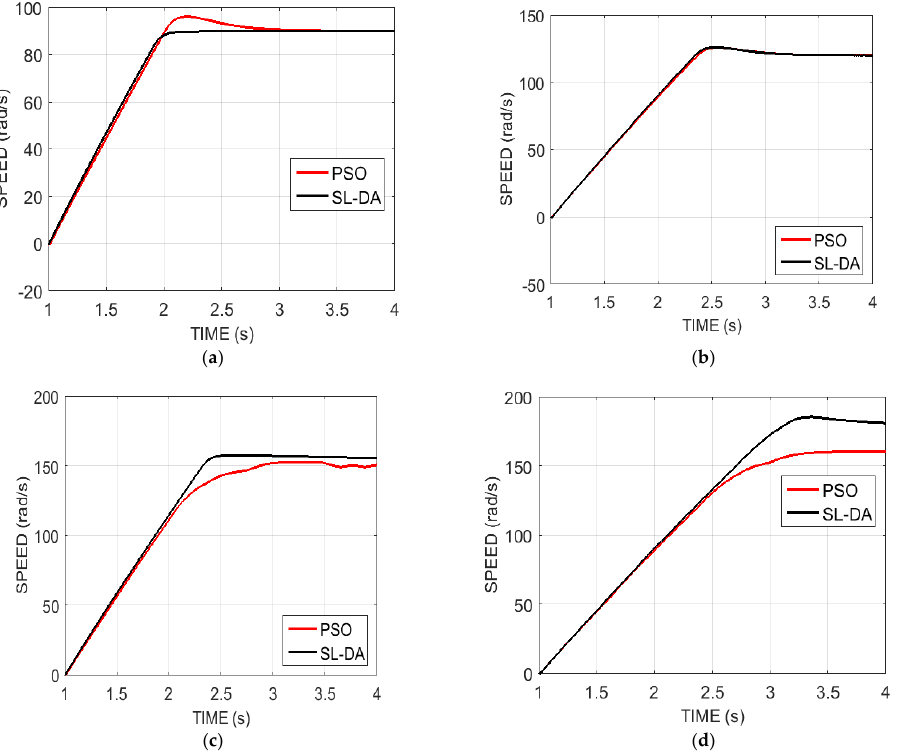
Figure 11. Speed analysis of proposed work over conventional models: ( a ) speed 90 and torque 130; ( b ) speed 120 and torque 150; ( c ) speed 150 and torque 180; and ( d ) speed 180 and torque 200.